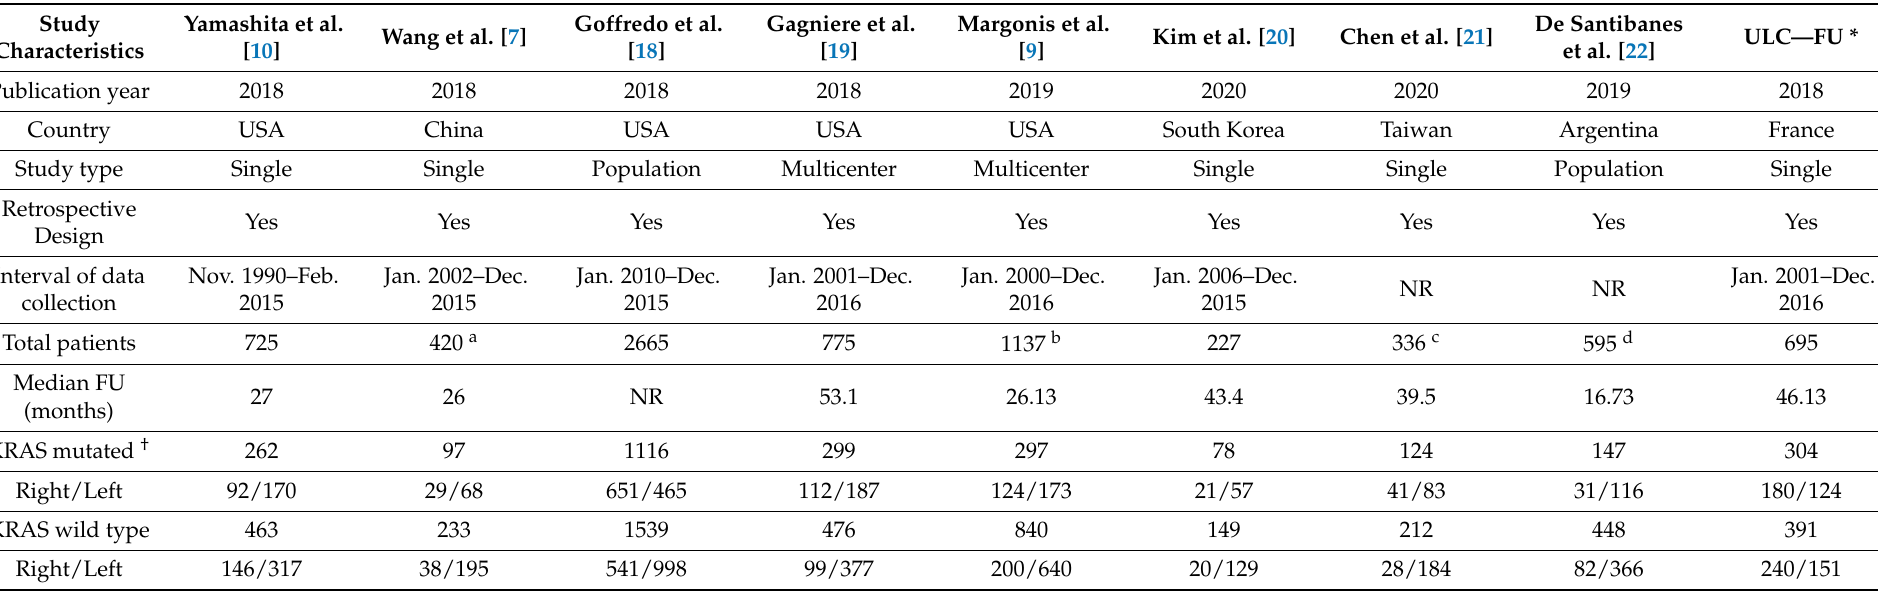
Table 1. Study characteristics and variable of